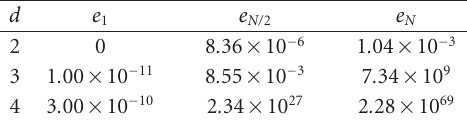
Table 6.6. Approximate error for Example